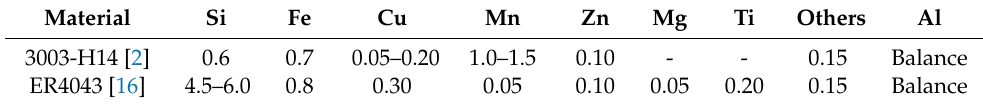
Figure 1. Single V-groove join preparation for the 3003-H14 aluminum alloy plates, showing the welding direction and thermocouples ( T 1 , T 2 , and T 3 ) location according to the global coordinate system ( X , Y , Z ). Dimensions are in mm. Table 1. Chemical composition of the materials used (weight percent)